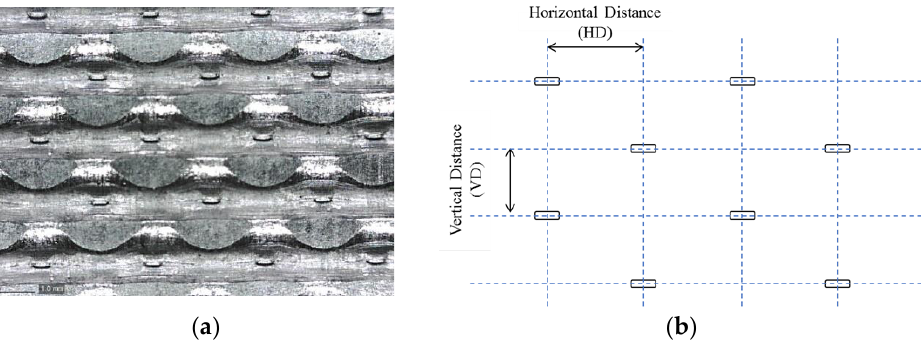
Figure 1. The expanded metal mesh (EMM): ( a ) the surface texture of the EMM; and ( b ) the perforation diagram of the EMM.